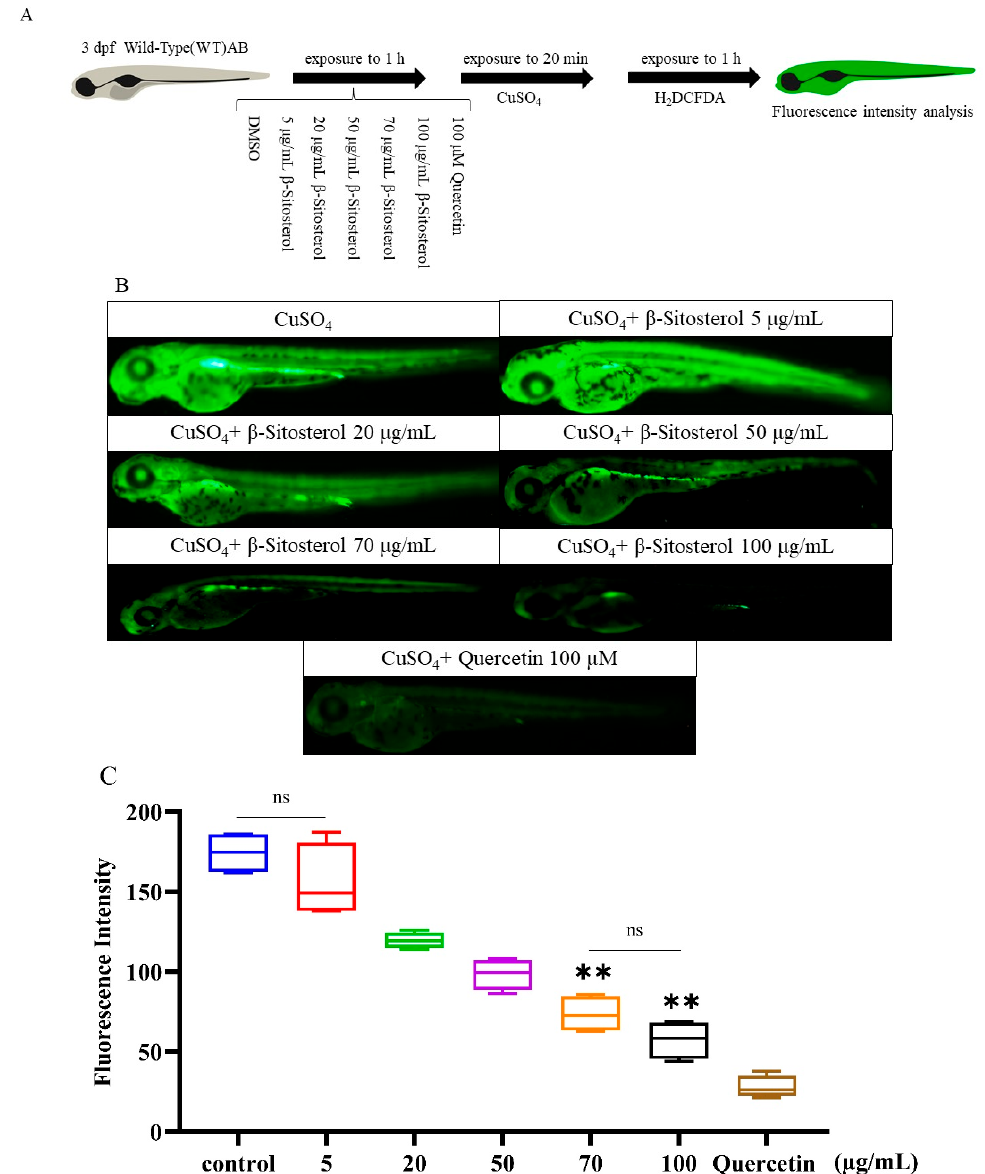
Figure 3. Inhibitory effect of β -sitosterol on the CuSO 4 -induced production of ROS in zebrafish larvae: ( A ) flowchart of the experiments; ( B ) representative fluorescence images of zebrafish in different experimental groups; ( C ) fluorescence intensity in juvenile zebrafish in different experimental groups compared with the group treated with CuSO 4 alone. ns, no statistical significance, ** p < 0.01 compared with the control group ( n = 4).